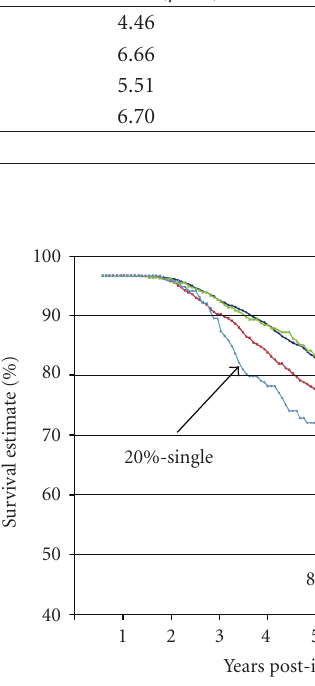
Figure 5: Survival function for 4 groups. The group variable, percent pacing, and pacemaker type had a significant impact on survival. Throughout the followup period, patients with dual- chamber pacemakers were least likely to die, regardless of whether they had < 20% or > 80% pacing. Patients with < 20% and single- chamber pacemakers had both the highest percentage of patients who died (30.8%) and the shortest time to death (25% died by 4.5 years post implant). Patients with > 80% and single-chamber pacemakers also had a high percentage, who died (30.5%), and a moderate survival time (25% died by 5.2